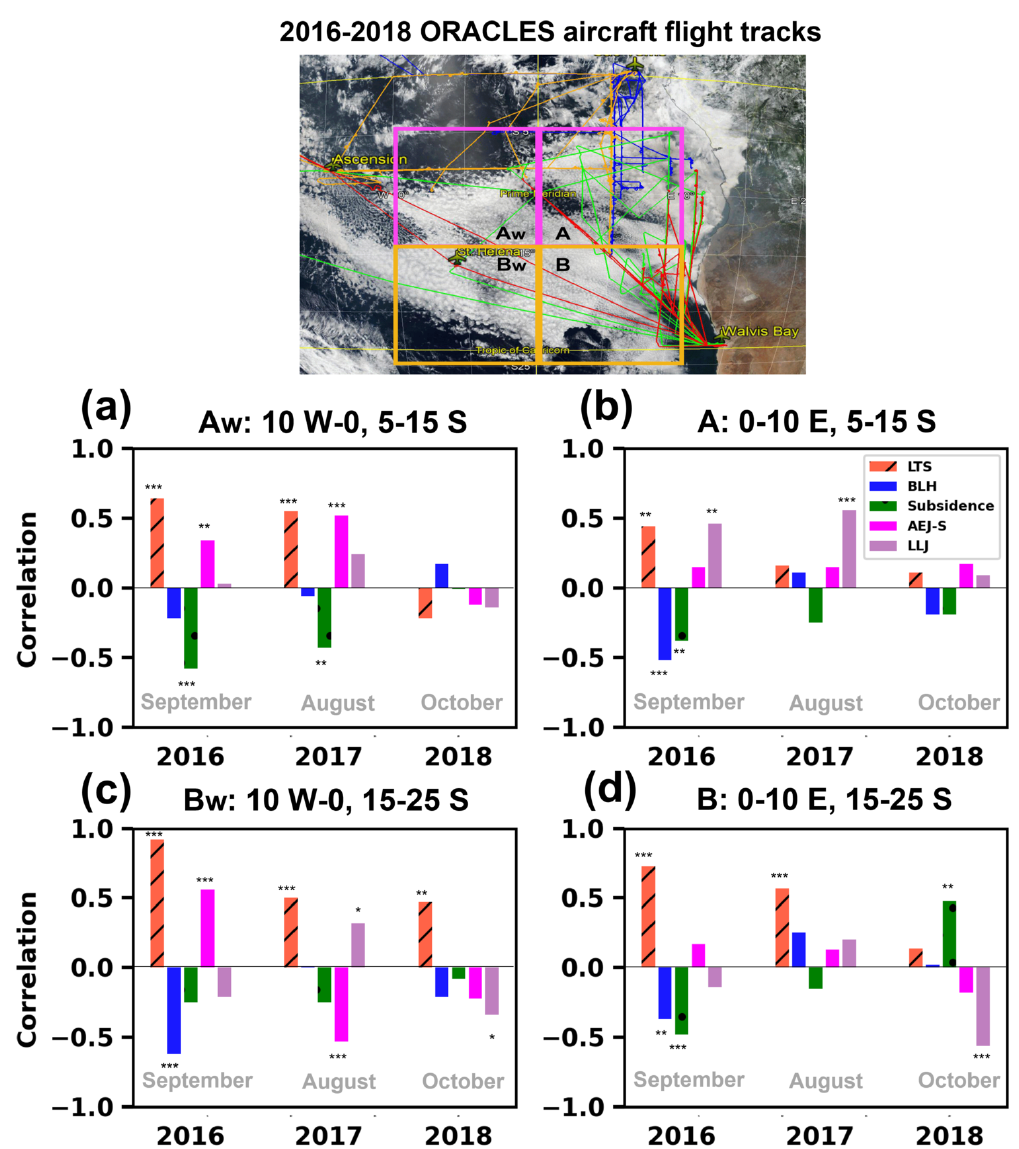
Figure 17. Bar plots of the linear correlation between daily mean low CF and daily mean of the meteorological variables (LTS, BLH, subsidence, AEJ-S, and LLJ) averaged over four subregions in the ORACLES flight regions over the SE Atlantic Ocean ( a Aw is 10 ◦ W–0 ◦ , 5–15 ◦ S; b A is 0–10 ◦ E, 5–15 ◦ S; c Bw is 10 ◦ W–0 ◦ , 15–25 ◦ S; d B is 0–10 ◦ E, 15–25 ◦ S) during the deployment months (marked in the boxed regions over the top image with flight tracks). A and B correspond to the regions A and B shown in the previous figures (e.g., Figs. 3, 4, 6, 8, 9, 11, 13, 14, and 16), while Aw and Bw correspond to the west of the regions A and B, respectively. The asterisks ∗∗∗ ( ∗∗ and ∗ ) denote when the correlation is statistically significant within 99% (95% and 90%) confidence interval ( p value < 0 . 01 ( < 0 . 05 and < 0 . 1)). The top panel represents the ER-2 flight tracks in 2016 (green) and the P-3 flight tracks in 2016, 2017, and 2018 (red, orange, and blue, respectively). The top panel, with flight tracks on a MODIS image and © Google Maps on 13 September 2018, is adapted from Redemann et al.